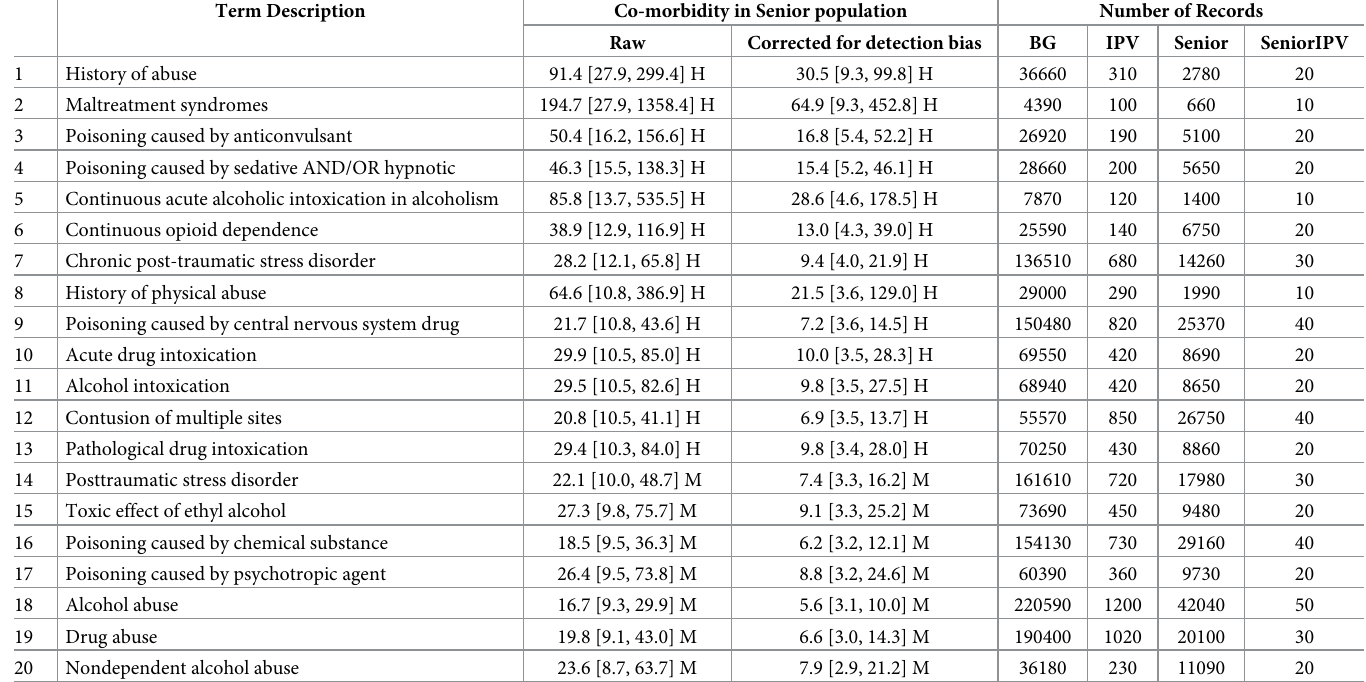
Table 1. Top 20 terms having high co-morbidity with IPV in older women population. For each term, we report both the raw co-morbidity scores (the odds ratios) and their corrected versions to alleviate the detection bias. For each co-morbidity score, we report the following: The point estimate (odds ratio), 95% augmented confidence interval corrected to bound FDR, and the corresponding co-morbidity level. The co-morbidity levels are abbreviated: H for high, M for moderate, and m for minor. The terms are sorted in descending order according to the minimum bound of their confidence intervals OR min (t, IPV|Senior). This table reports the top 20 terms that exhibit high (OR � 10) or moderate level of association (OR � 5) with IPV in the older women population. See S2 Data for a full list of terms identified as significant. OR: Odds ratio, IPV: Intimate partner